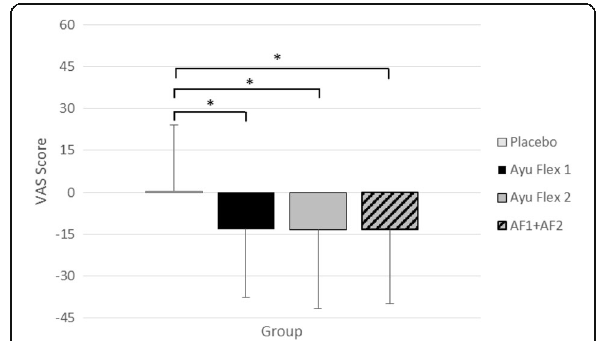
Fig. 7 Mean ± SD changes in VAS scores for knee discomfort. Significant differences were noted between the active groups (AF1, AF2, and AF1 + AF2) vs. Placebo. See Table 5 for